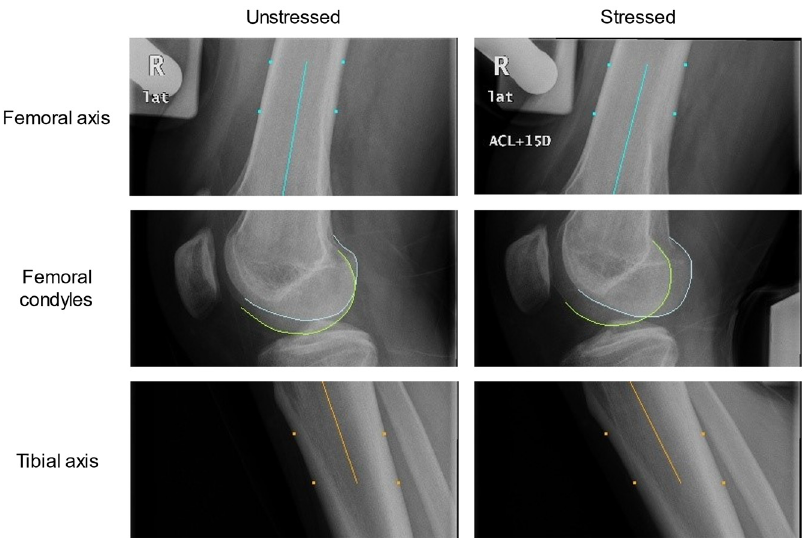
Figure 3. The segmentation results of stress radiography for anterior cruciate ligament (ACL) in- jury. In this case, the lateral (lat) projection views of the right (R) knee before and after exerting a force of 15 daN (+15D) posteriorly on the tibia by a stress device were taken. The anterior edge and the posterior edge of both femur and tibia were segmented (cyan and orange dots) and used to calculate the femoral axis and the tibial axis (cyan and orange straight lines). The condyle contours (white and yellow curves) were also segmented.